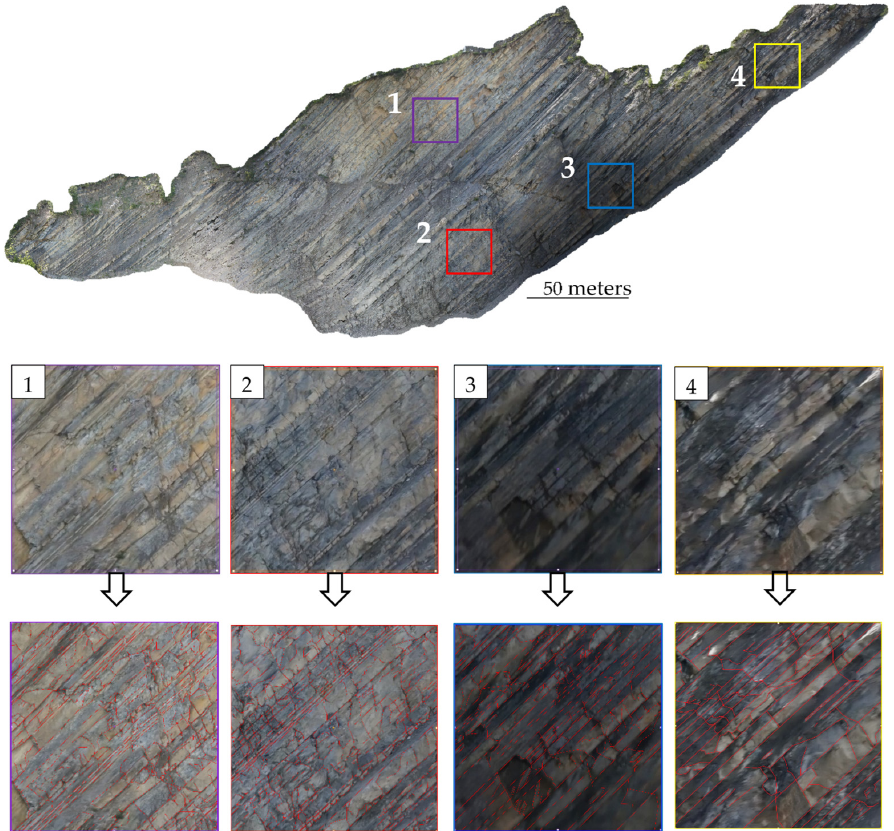
Figure 9. Orthomosaic of the Poggio Baldi rock scarp, with 20 × 20 m frames for each source sector ( top ). Details of source sector frames (1, 2, 3, and 4), with the manually traced fractures in red ( bottom ).